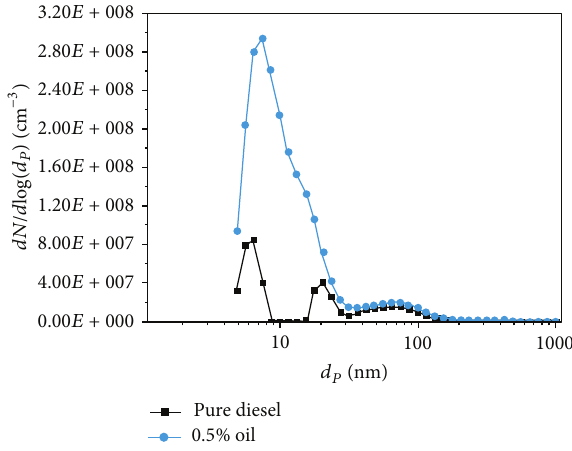
Figure 5: Particle size distributions at the speed of 2000 rpm/25% load.